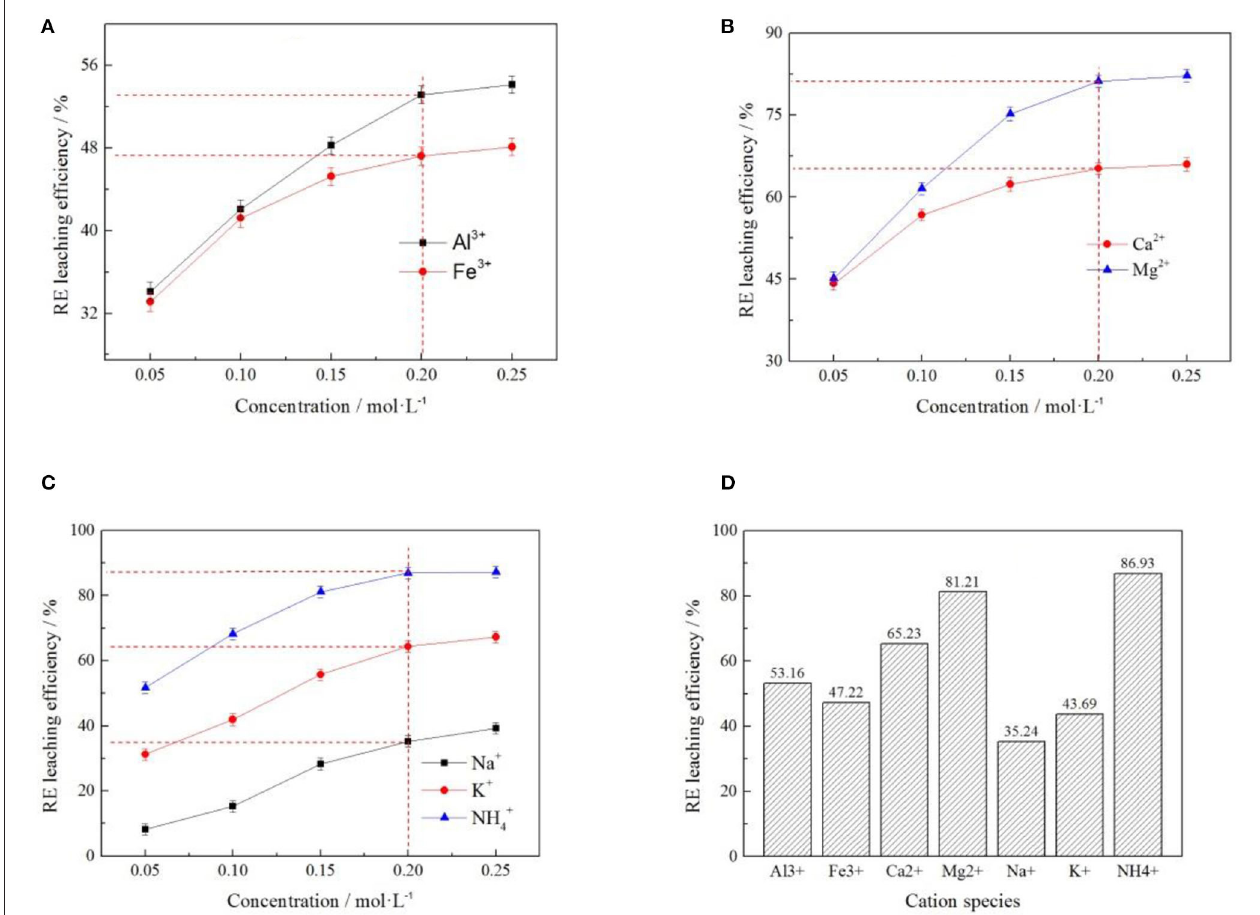
FIGURE 6 | Effect of cation concentration on rare earth leaching efficiency [where (A?C) represent + 3, + 2, and + 1 valence cations respectively, (D) represents the rare earth leaching efficiency when the concentration of various cations was 0.2 mol/L].